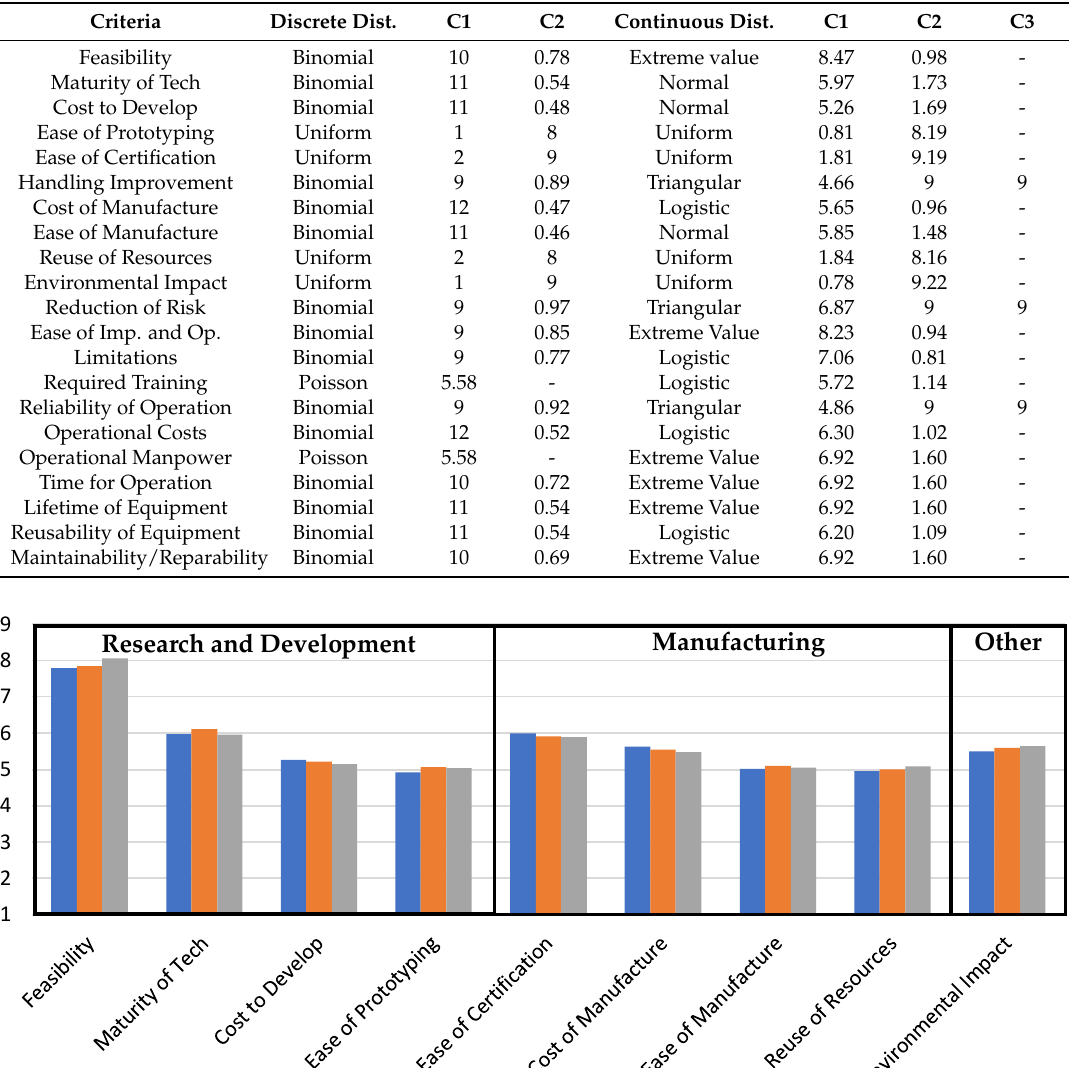
Table 5. Fitted distributions of weighting response data.